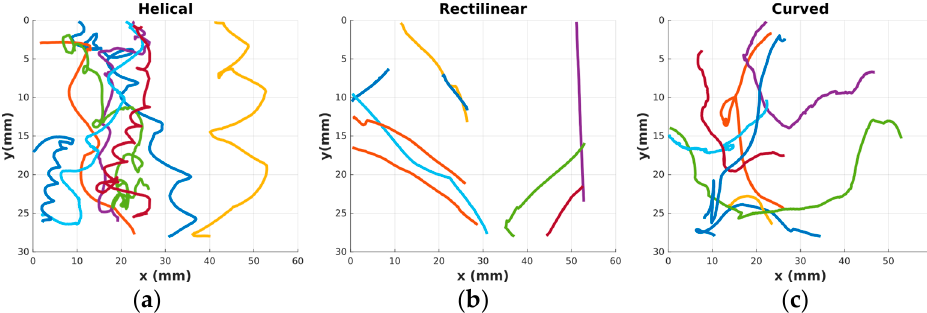
Figure 2. Examples of trajectory types observed in Temora turbinata under experimental conditions, including controls and treatments: ( a ) helical-like (n = 158), ( b ) rectilinear (n = 13) and ( c ) curved (n = 482). The instantaneous swimming speeds (Figure 3) were significantly lower in copepods exposed to plastic microbeads compared to the control, the same trend being observed for mean swimming speeds (Figure 4). The effect of the high MP concentration on the swimming performance of T. turbinata was more clearly discerned in the mean speeds (Figure 4; Table 1).